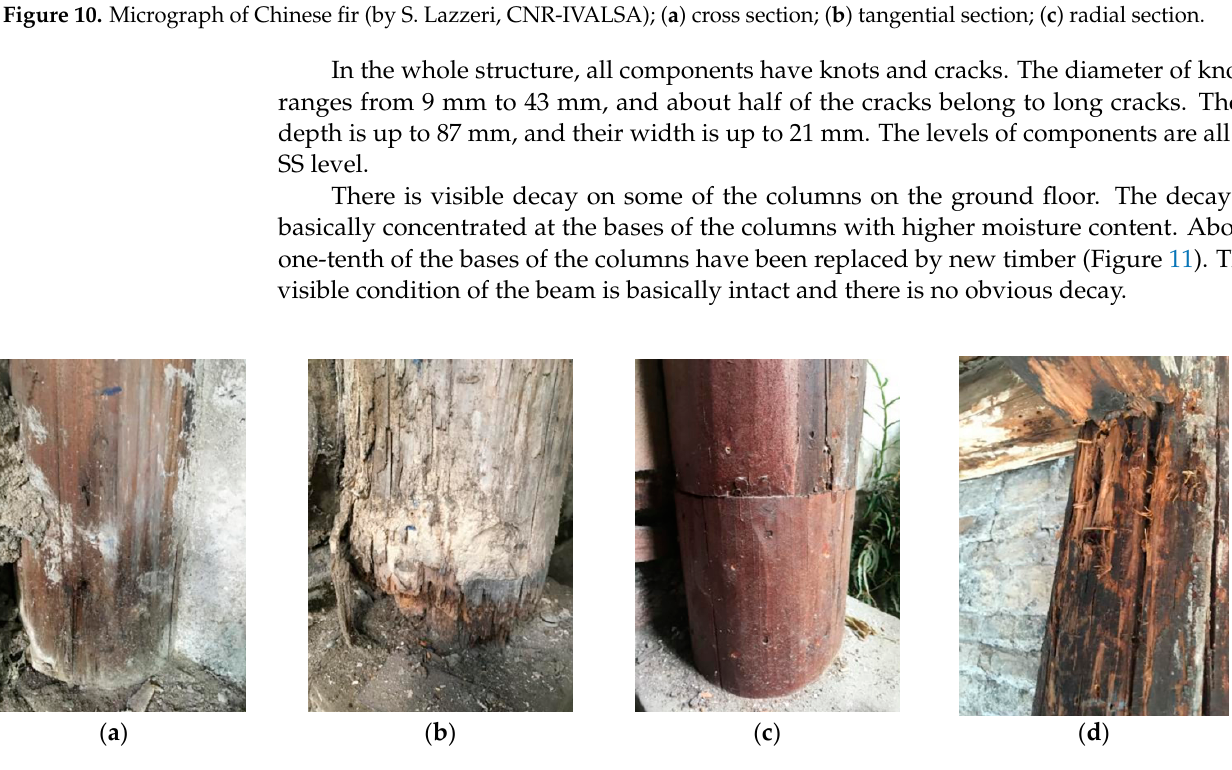
Figure 11. Appearance survey of Fujiu Zhou house; ( a ) column base influenced by fungi; ( b ) decay of column base; ( c ) new timber replaced the column base; ( d ) decay of the beam-column joint.